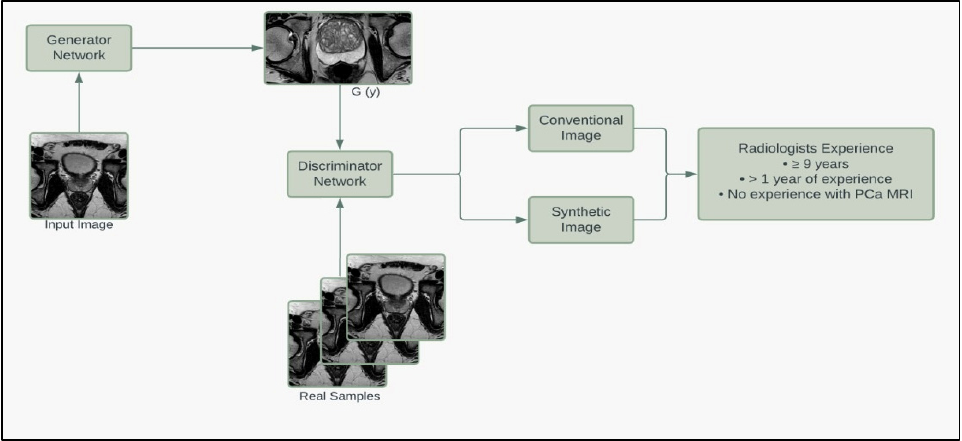
Figure 5. Model framework diagram of the corresponding generators and discriminators in the SinGAN network.